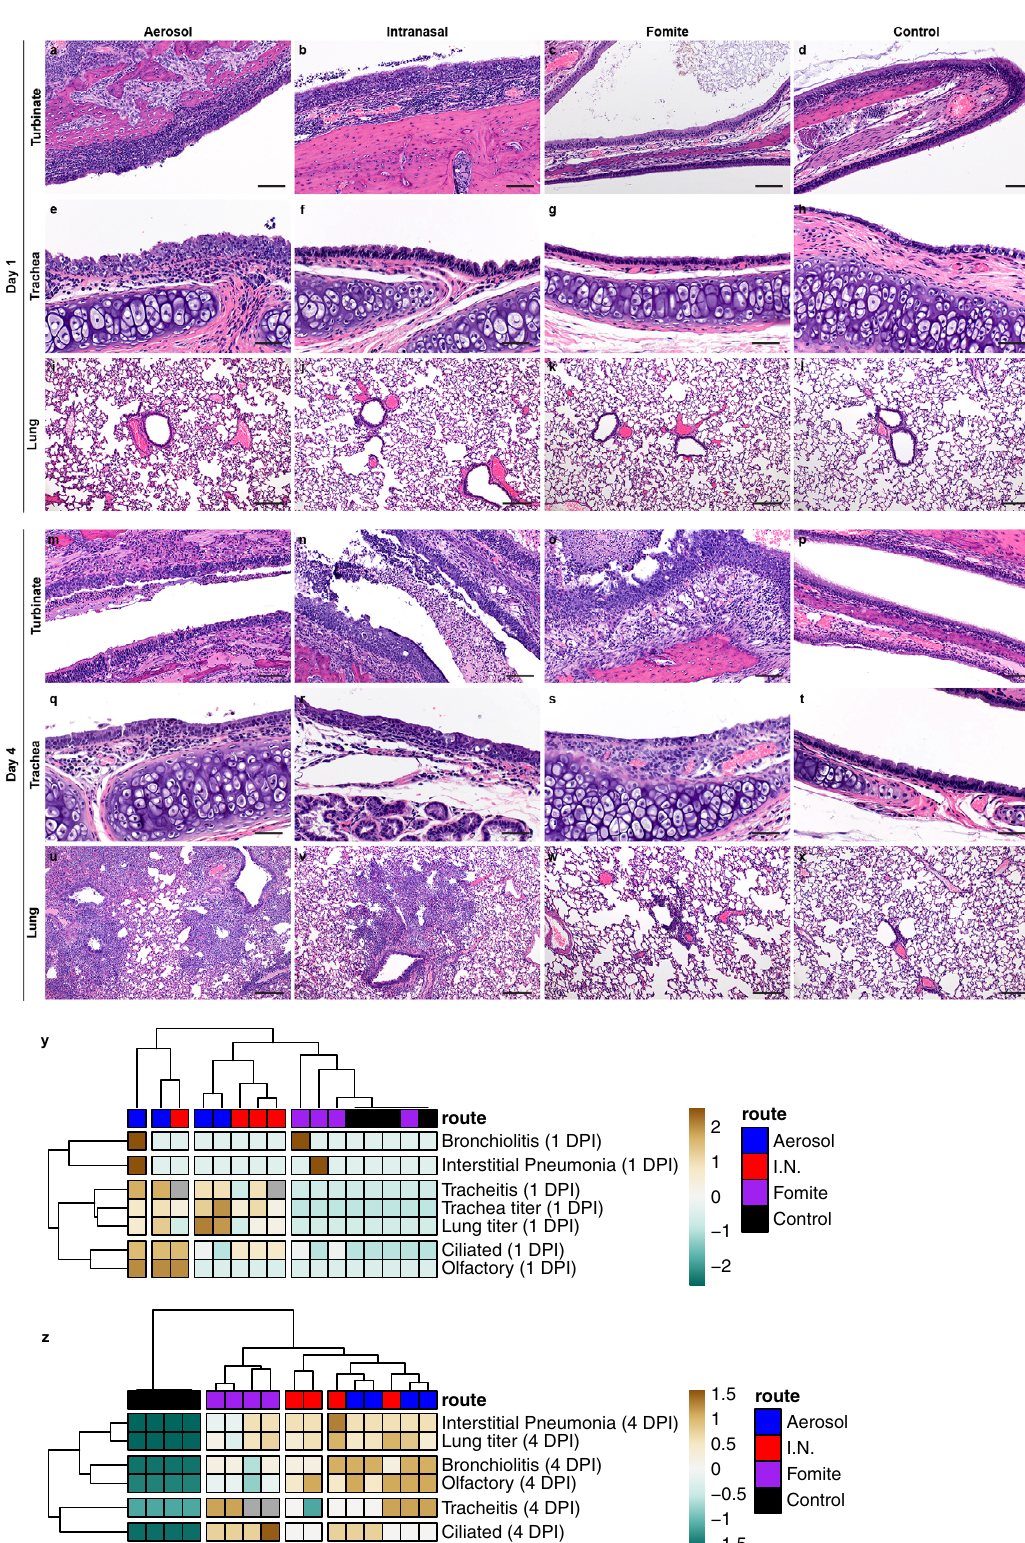
Fomite SARS-CoV-2 exposure results in a reduced immune pro fi le in the lung . To investigate the systemic immune response, cytokine speci fi c ELISAs were performed on serum at 4 DPI (Fig. 4a). While overall signi fi cance was low, serum levels were different depending on exposure route for pro-in fl ammatory tumor necrosis factor (TNF)- α and anti-in fl ammatory interleukin